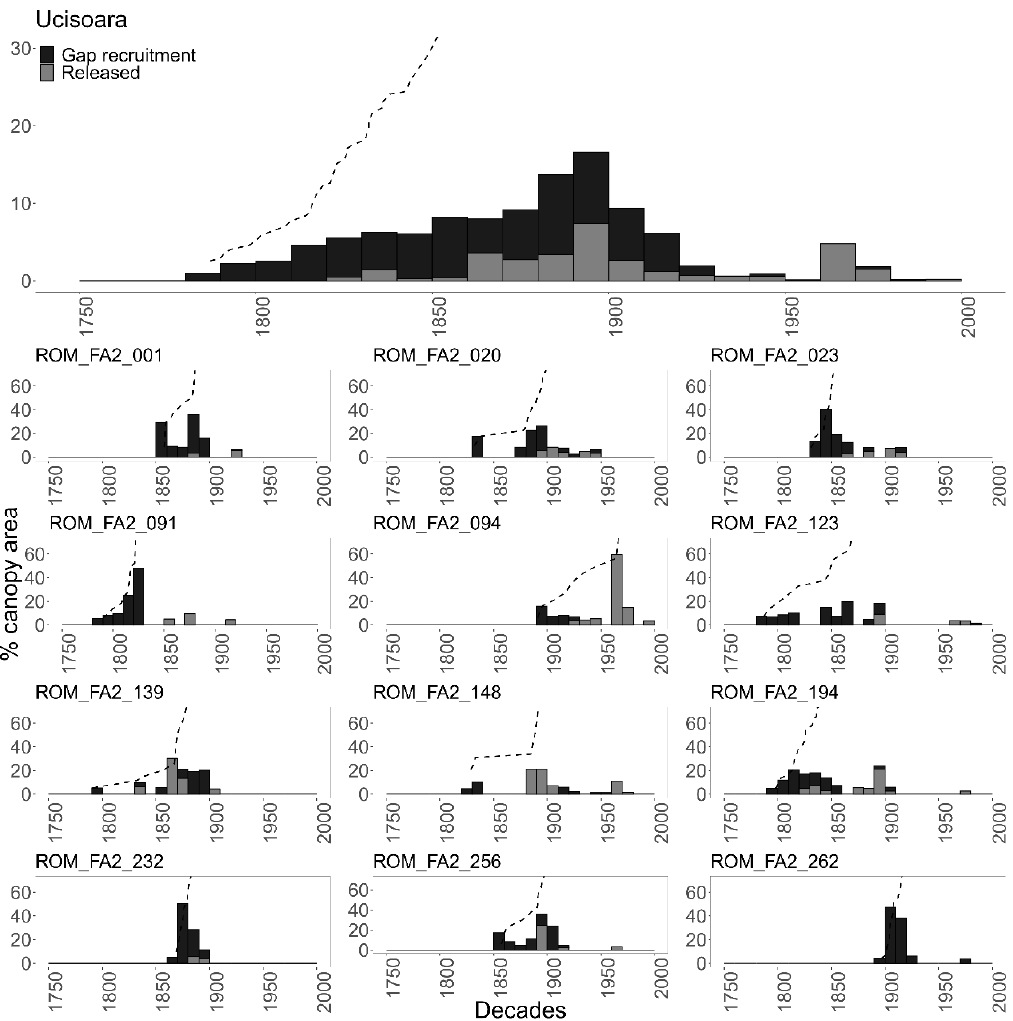
Figure 3. Disturbance history reconstruction summed per decade as a percent of canopy disturbed for the Southern Carpathian region: all plots pooled ( top ) and at stand level ( down ). Sample depth ( dark grey line ) represents the cumulative number of trees contributing to the chronology. The chronologies were derived from analysing two types of events characteristic for disturbances: gap recruitment and growth releases.